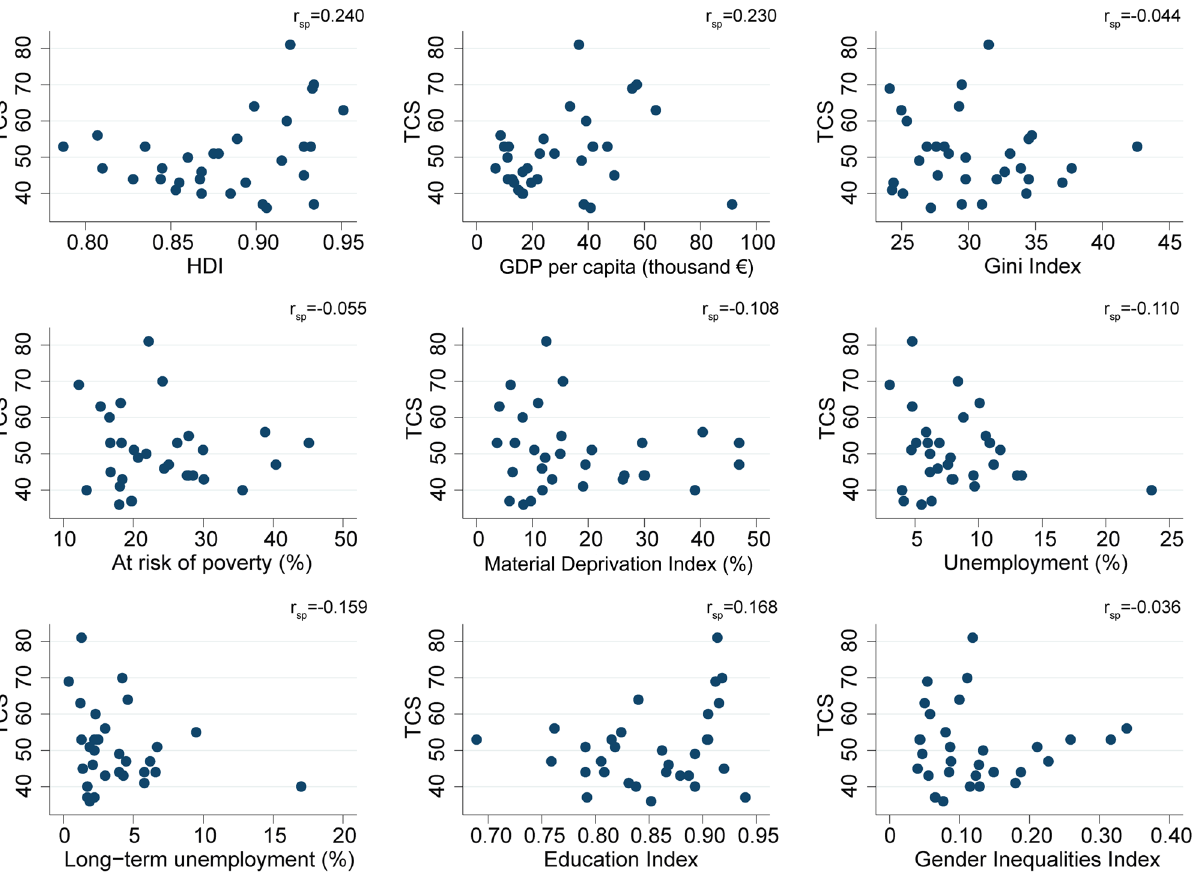
Figure 1. Correlation between Tobacco Control Scale (TCS) total scores and socioeconomic status (SES) indicators in 2016 in 31 European countries. *GDP: Gross Domestic Product, HDI: Human Development Index, MDI: Material Deprivation Index. r sp : Spearman-rank correlation